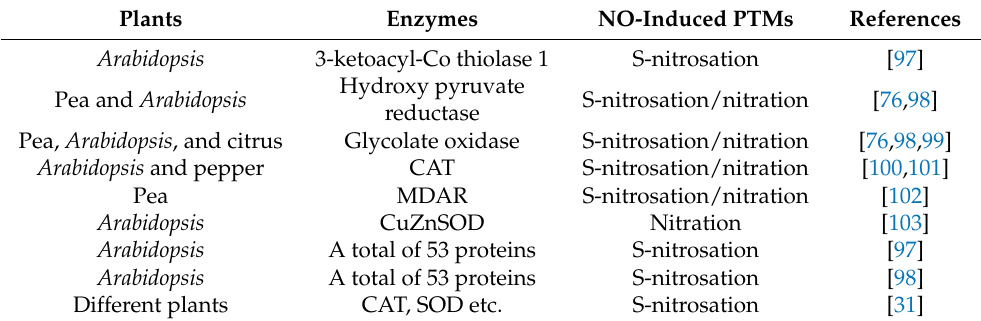
Table 1. PTMs induced by NO through S-nitrosation or tyrosine nitration. Plants